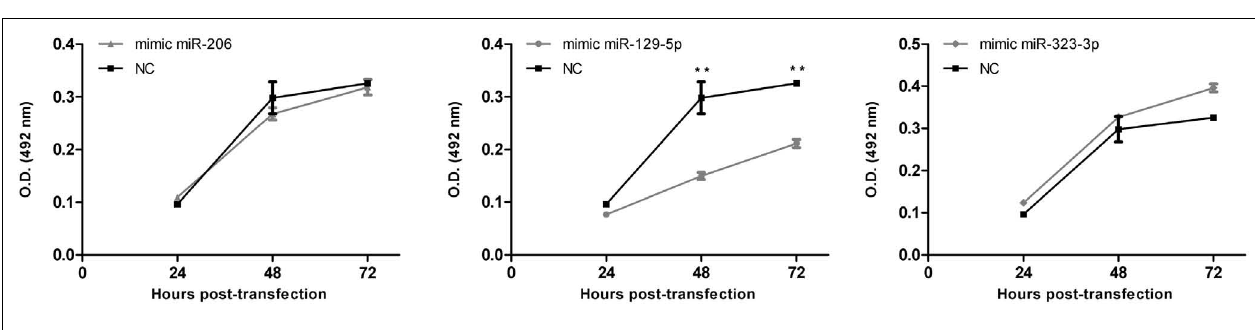
re-plating, thus after 24, 48, and 72h post-transfection. Results are representative of three independent experiments. Mean ± SE are shown; ** P < 0.01 according to two-tailed t -test; NC, negative control miRNA mimic